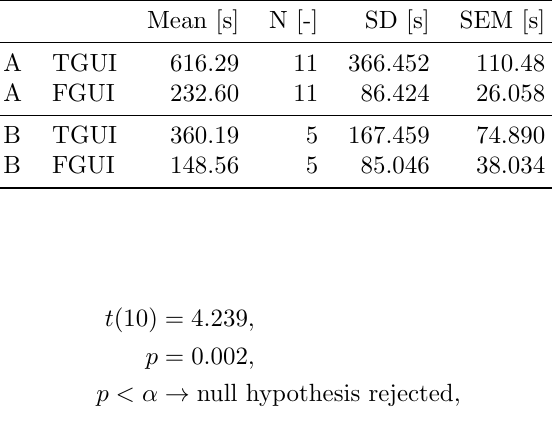
throughout the two